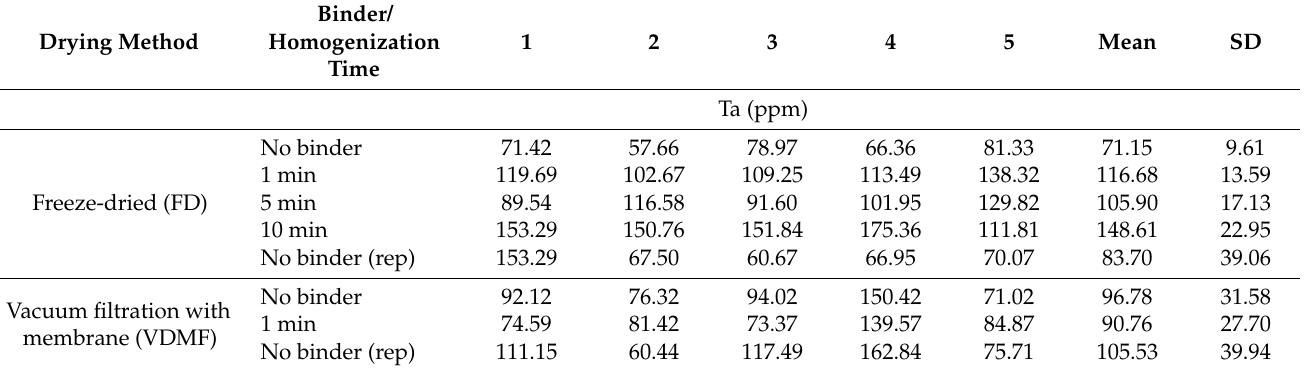
Table 4. Summary of the Ta concentrations (ppm) of the Penouta ore pellets obtained by LA-ICP- MS spot analysis following pellet production using different drying techniques. The values are based on data normalized to SiO 2 as an internal standard. SD = standard deviation; rep = repeated analytical